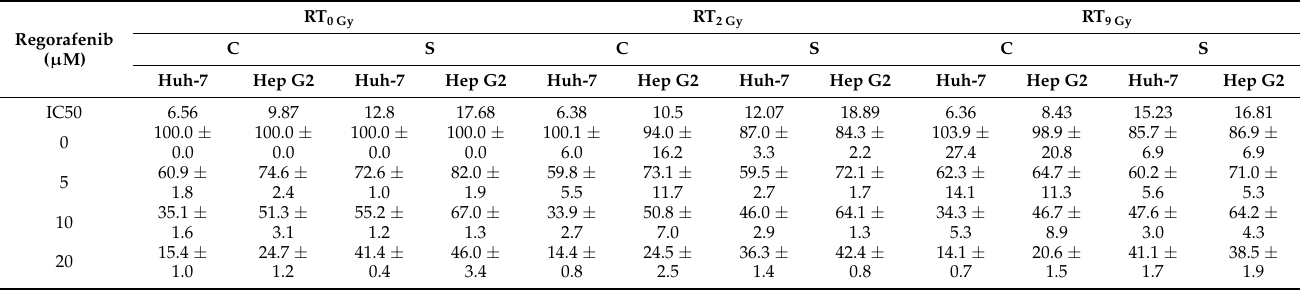
Table 3. The regorafenib concentrations studied ranged from 0 to 20 µ M concurrent with or following radiotherapy (RT) with sham RT (RT 0 Gy ), 2 Gy (RT 2 Gy ) and 9 Gy (RT 9 Gy ), and the estimated concentration at which 50% of cells were killed (IC50) for Huh-7 and Hep G2.